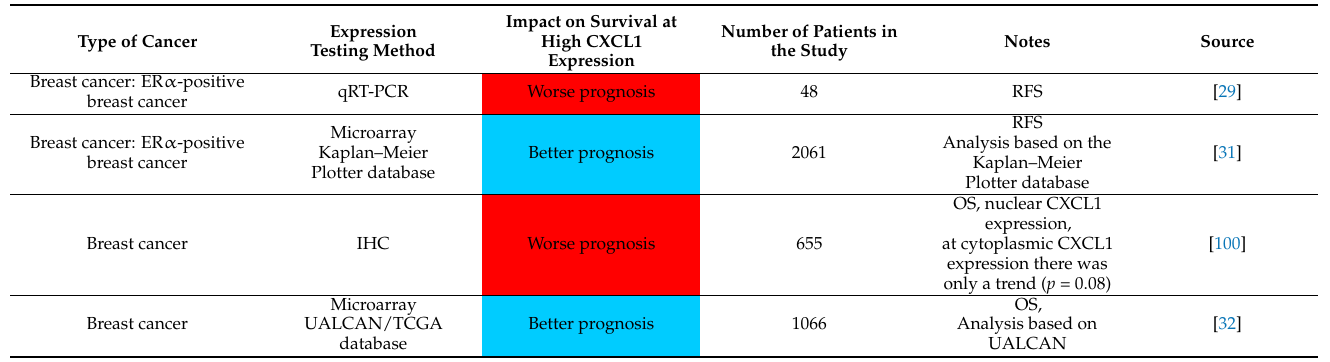
Table 1. Effect of CXCL1 expression level on survival of breast cancer